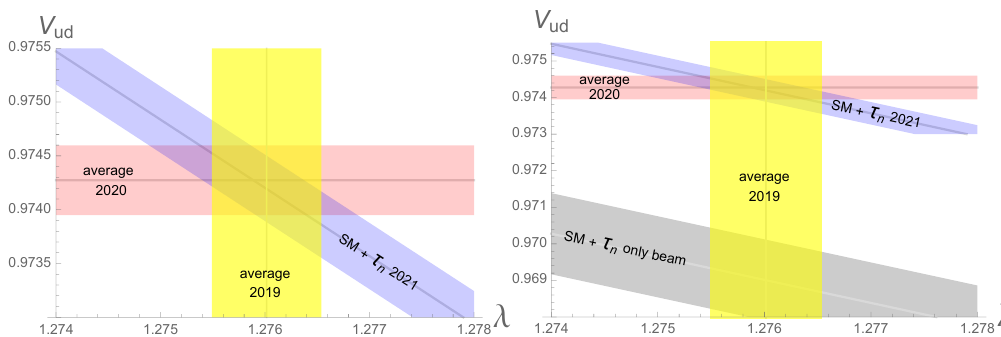
Figure 2 . Left: illustration of the compatibility, within the SM, among the determinations of and τ (tot). Right: enlargement of the parameter region to include the prediction of the λ , V ud n correlation λ − V (gray band) that follows from the SM assuming the correctness of measurement ud (beam): this is incompatible with the determinations of λ and V τ n